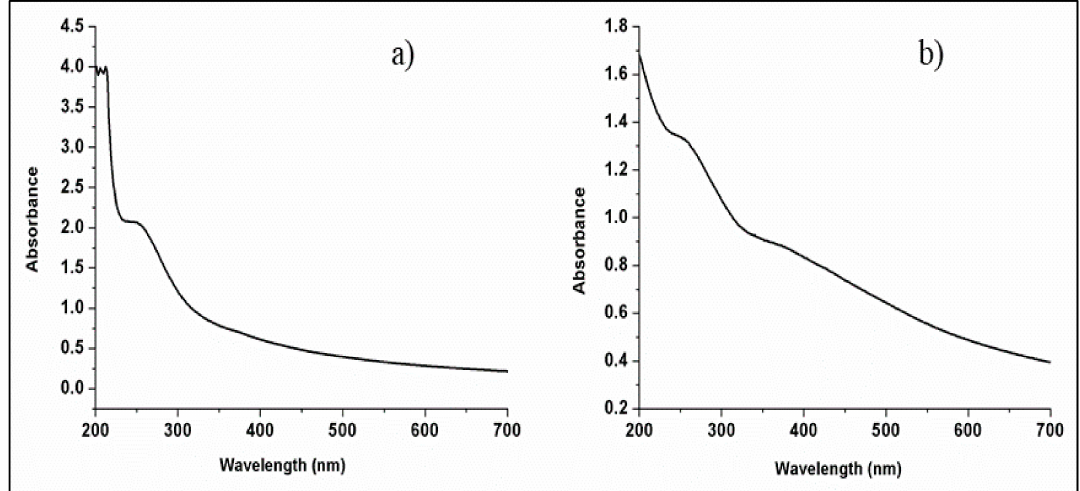
Figure 5. UV-Vis spectra: ( a ) MMT clay and ( b ) MMT/Ag nanocomposite. In the MMT clay sample, the characteristic bands are present in the ultraviolet region (200–400 nm), i.e., at 210 nm, 214 nm and 250 nm. Bands at 210 nm and 214 nm point to